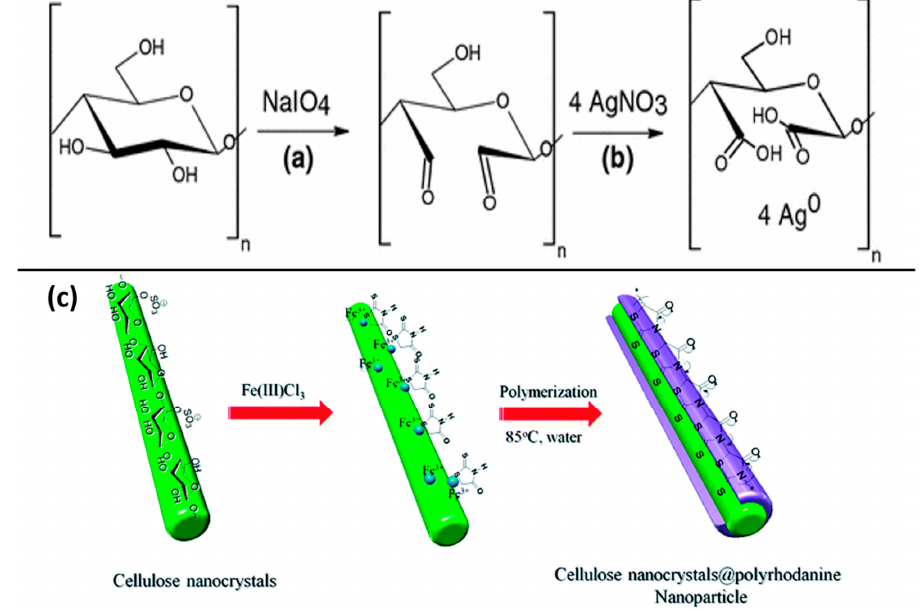
Figure 9. ( a ) Oxidation of CNC, ( b ) Reduction of Ag + to Ag o . Reproduced with permission from Drogat et al. [65]. Springer copyright © 2011 and ( c ) cellulose nanoparticles with polyrhodanine (CNC@PR) Fabrication. Reproduced with permission from Tang et al. [77]. RSC copyright ©